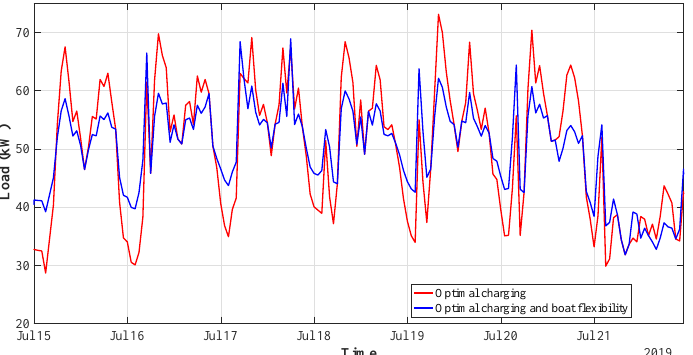
Figure 9. Marina’s load with optimal car charging and boat flexibility.